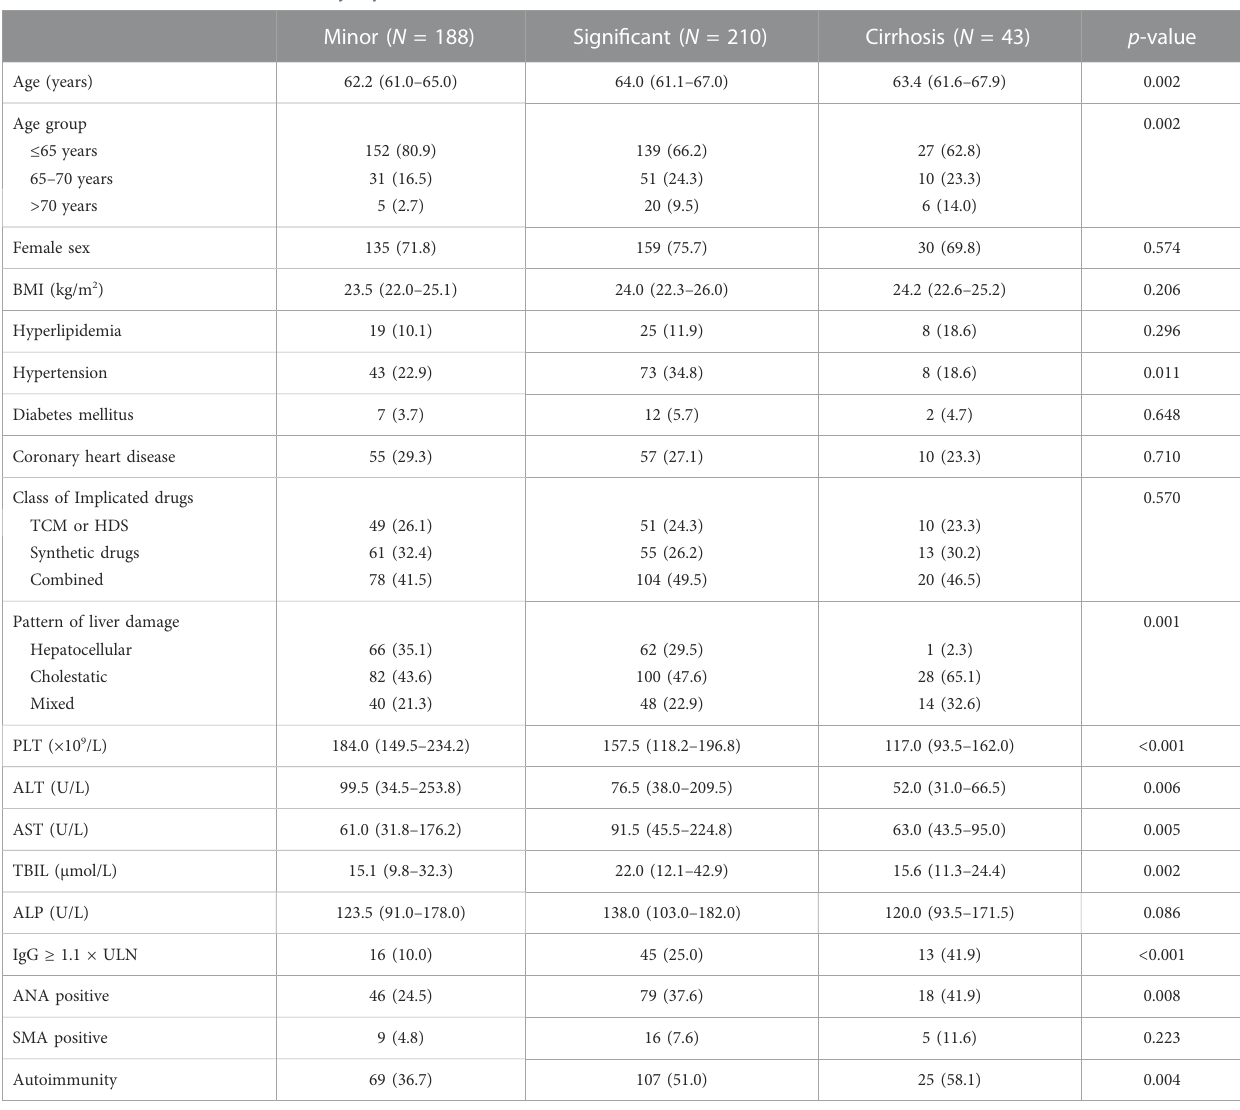
TABLE 2 Clinical characteristics strati fi ed by hepatic fi